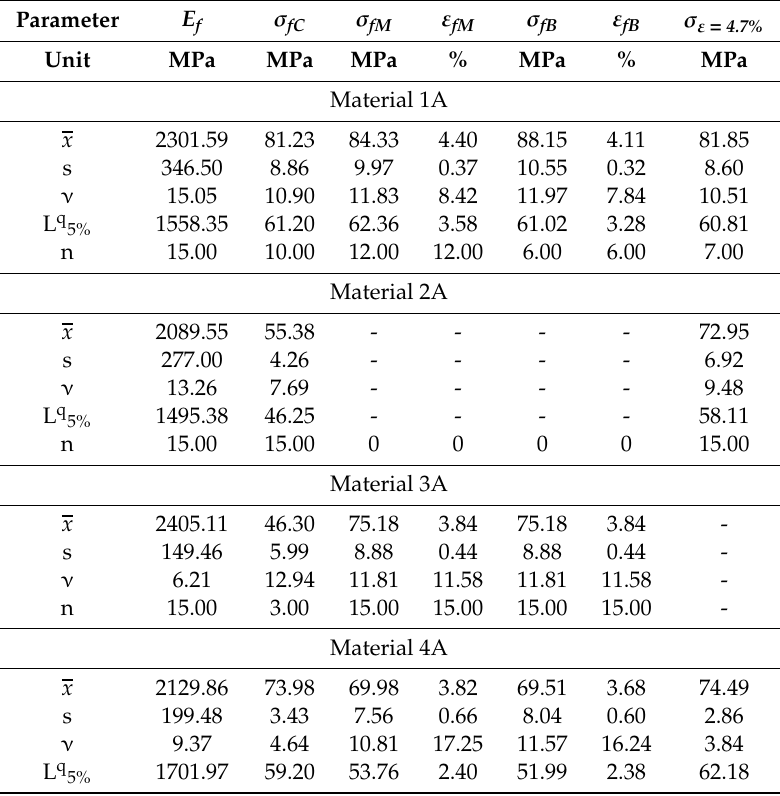
Table 2. Descriptive statistics of the results from the three-point bending test of the tested materials. Parameter E